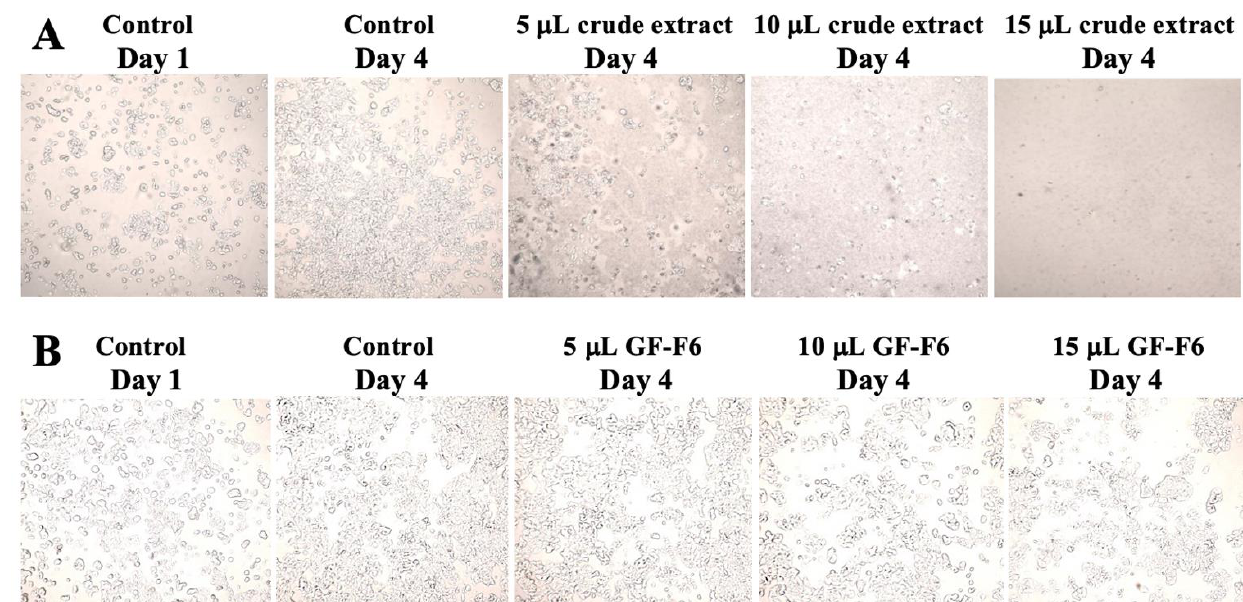
Figure 6. Cytotoxic and anti-proliferative activities of rhubarb stalks. Human breast cancer cells, MCF-7, were treated with either crude extract from rhubarb ( A ) or the gel-filtration purified fraction, GF-F6 ( B , C ), for the indicated times. The pro- portions of viable cells are shown in ( A , B ), while the total number of viable cells is shown in ( C ). Volumes of rhubarb extract or purified GF-F6 used were 0 μL (circles), 5 μL (squares), 10 μL (triangles), and 15 μL (diamonds). The average and standard deviations of each experiment done in triplicate are shown. Error bars are shown for all data points, but are not visible for some if they are smaller than the symbol sizes.